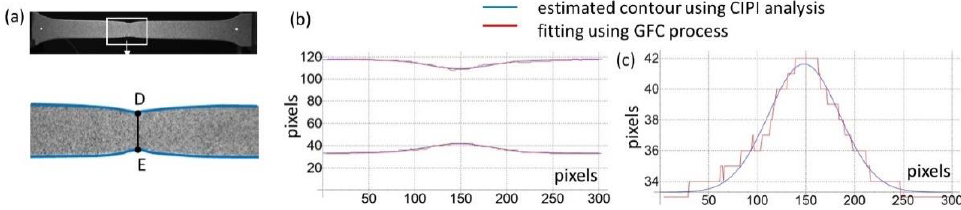
Figure 12. Identification of the specimen’s contour outline: ( a ) view of the specimen identification, ( b ) contour recognition using image processing, ( c ) detailed fitting using Gaussian curve.